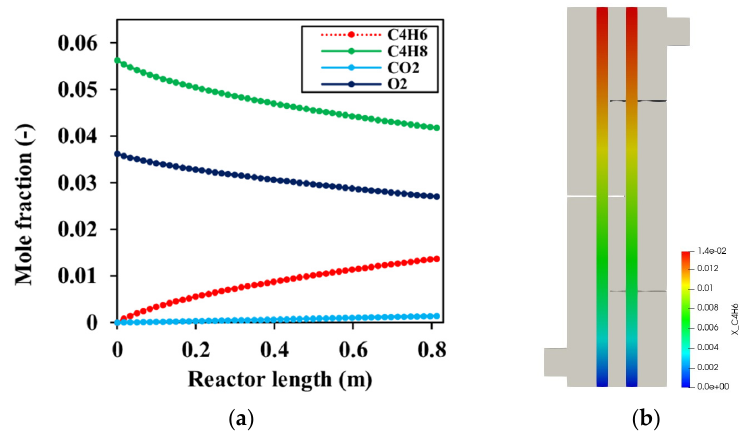
Figure 7. Mole fraction distribution and mole fraction contour plot under isothermal conditions: ( a ) mole fraction distributions of each species; ( b ) contour plot of butadiene mole fraction.